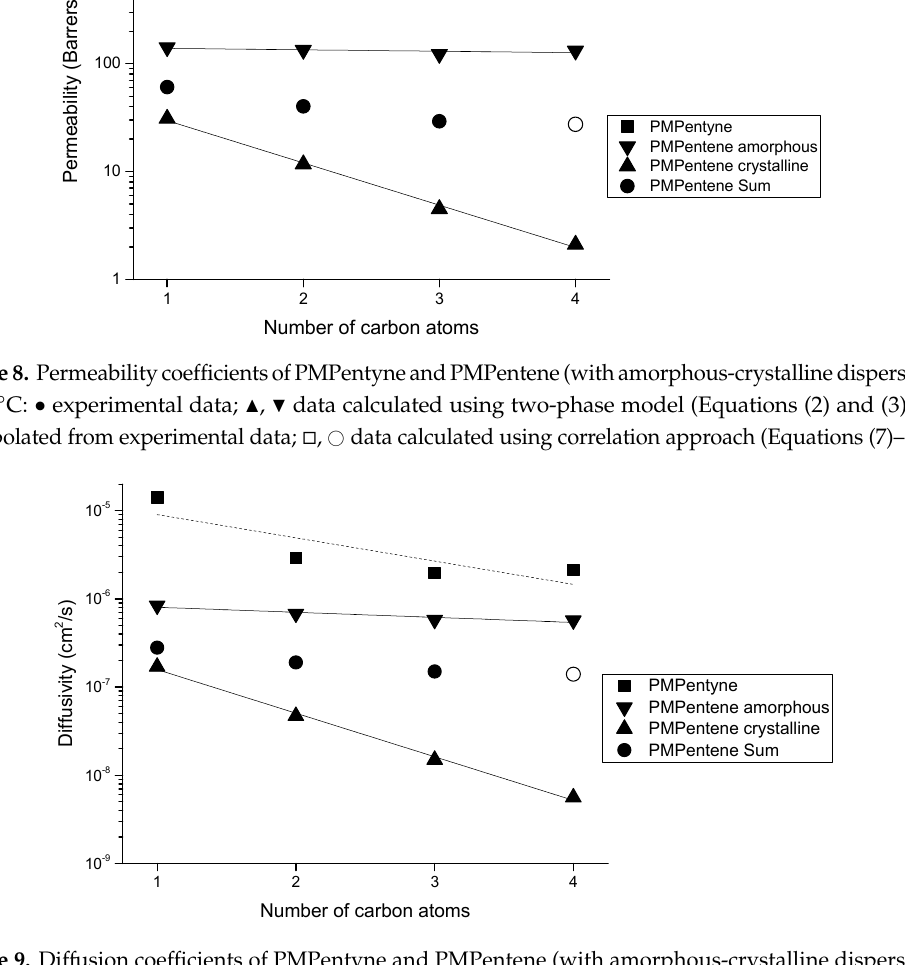
Figure 9. Di ff usion coe ffi cients of PMPentyne and PMPentene (with amorphous-crystalline dispersion) Figure 9. Diffusion coefficients of PMPentyne and PMPentene (with amorphous-crystalline dispersion) at 80